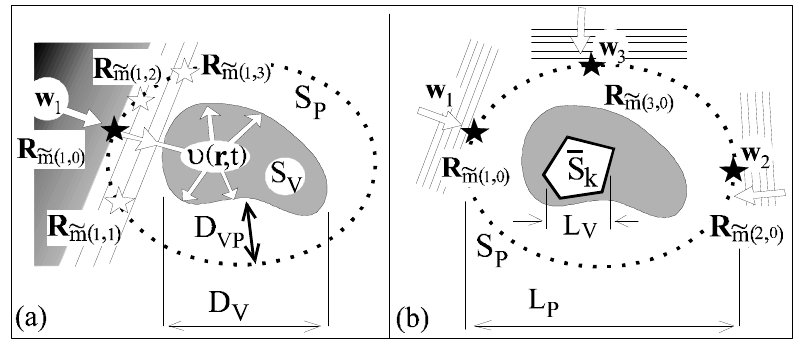
Figure 11. Targeting of one (a) and three (b) incident waves. Incident wave (a) forms the bearing group of microphones (one title microphone and three benchmark ones) on the surface S to match with the surface S of a protected body, covered by an active p V coating with pistons S . Three incident waves (b), arriving from different directions 1 w , k w , w create three nonintersecting bearing 2 3